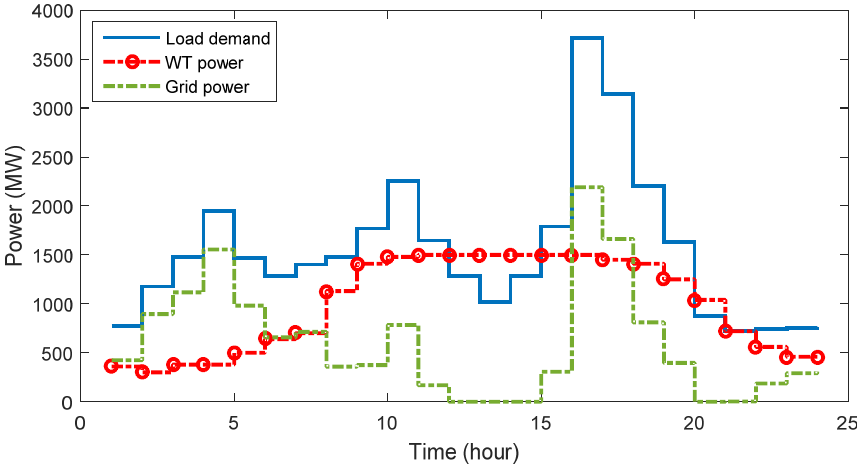
Figure 13. Contribution of wind power, grid power, and load demand for 24 h.